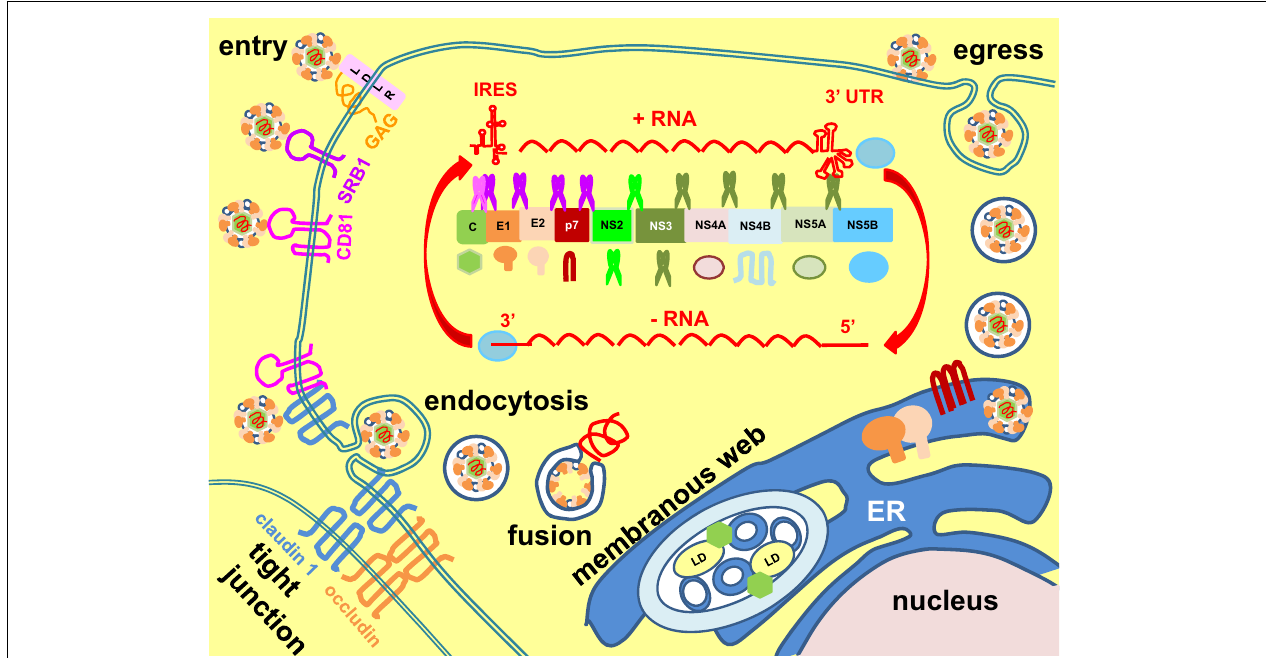
FIGURE 1 | Hepatitis C virus life cycle. Hepatitis C virus enters cells by stepwise binding through host receptors low-density lipoprotein receptor (LDLR), glycosaminoglycans (GAGs), scavenger receptor class B member 1 (SRB1), CD81, and the tight junction proteins claudin 1 and occludin. Interaction between CD81 and claudin 1 facilitates viral uptake by clathrin-mediated endocytosis. Endosomal low pH triggers membrane fusion and release of genome into the cytoplasm. The positive-sense ( + ), single-stranded RNA is translated by an internal ribosome entry site (IRES) element at its 5 (cid:2) untranslated region (UTR) into a single polypeptide, which is then cleaved into the core, E1, E2, p7, NS2, NS3, NS4A, NS4B, NS5A, and NS5B by host signal peptidase (purple scissor) and signal peptide peptidase (pink scissor) and viral autoprotease (NS2-3) (fluorescent green